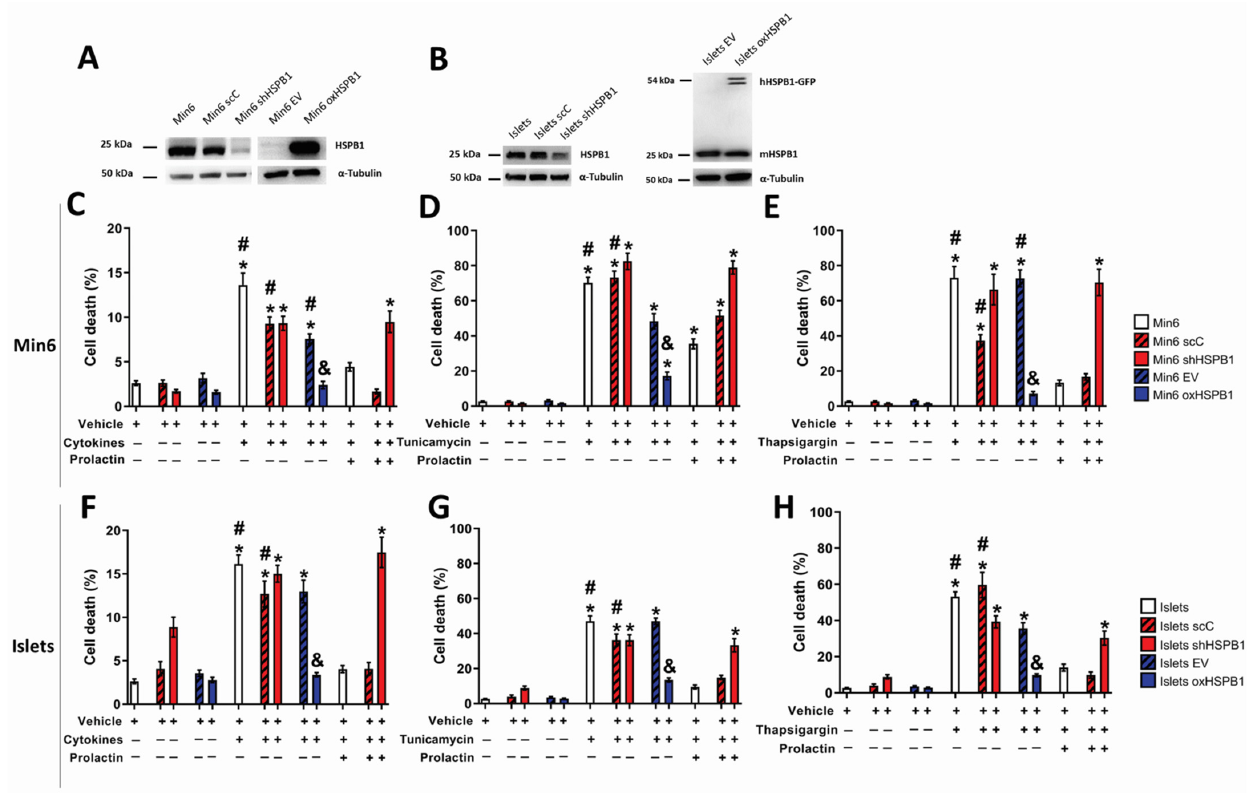
Figure 1. HSPB1 is a key mediator of prolactin-mediated cytoprotection against ER stress in Min6 cells and mouse islets. HSPB1 expression was confirmed by Western blot in ( A ) Min6 cells and ( B ) mouse islets. HSPB1-silenced (Min6 shHSPB1, Islets shHSPB1) and HSPB1-overexpressing (Min6 oxHSPB1, Islets oxHSPB1) Min6 cells and mouse islets, as well as their respective controls (Min6 scC, Min6 EV; Islets scC, Islets EV), were exposed to a combination of cytokines ( C , F ) (TNF- α 8 ng/mL, INF- γ 16 ng/mL, IL-1- β 1.6 ng/mL), ( D , G ) tunicamycin (15 or 7.5 µg/mL, respectively), or ( E , H ) thapsigargin (75 nM) in the presence or absence of PRL (300 ng/mL) for 16 h. Cell death was evaluated by PI/Hoechst staining using fluorescent microscopy. Results are presented as means ± SEM (each data point represents the mean ± SEM from three replicates of at least three independent experiments); * p < 0.05 vs. control (vehicle); # p < 0.05 vs. PRL; & p < 0.05 vs. EV.